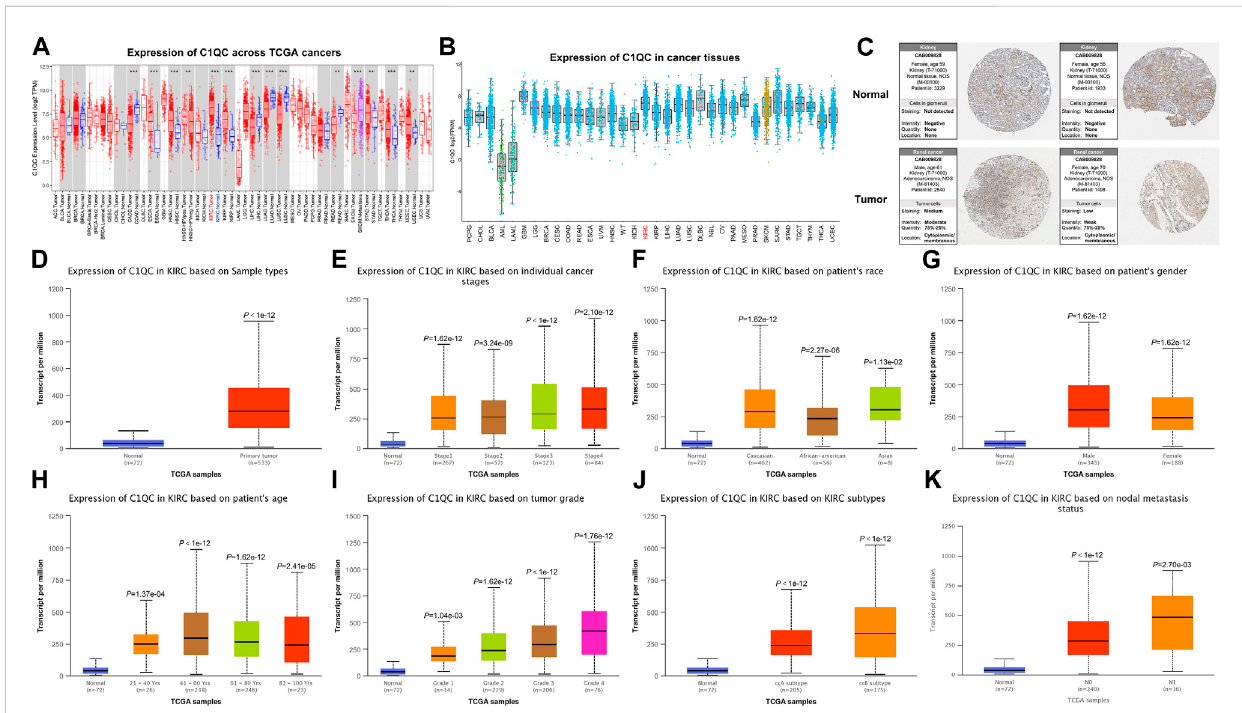
FIGURE 1 C1QCexpressionoverview. (A) C1QCmRNAexpressioninavarietyofcancertissuesincomparisonwithnormaltissues(* p < 0.05,** p < 0.01,*** p